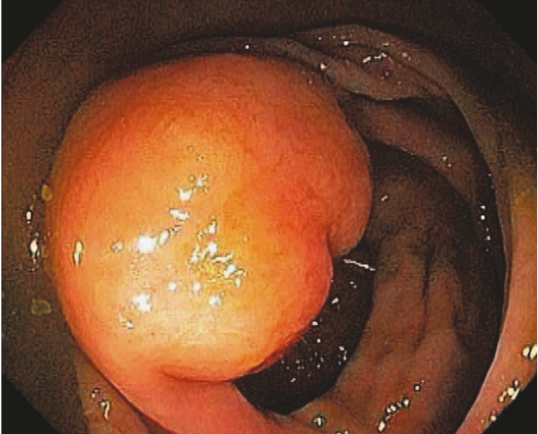
Figure 5: Endoscopic image of lipomatous hyperplasia of the ileocecal valve due to focal proliferation of adipose tissue within the submucosa of the valve.